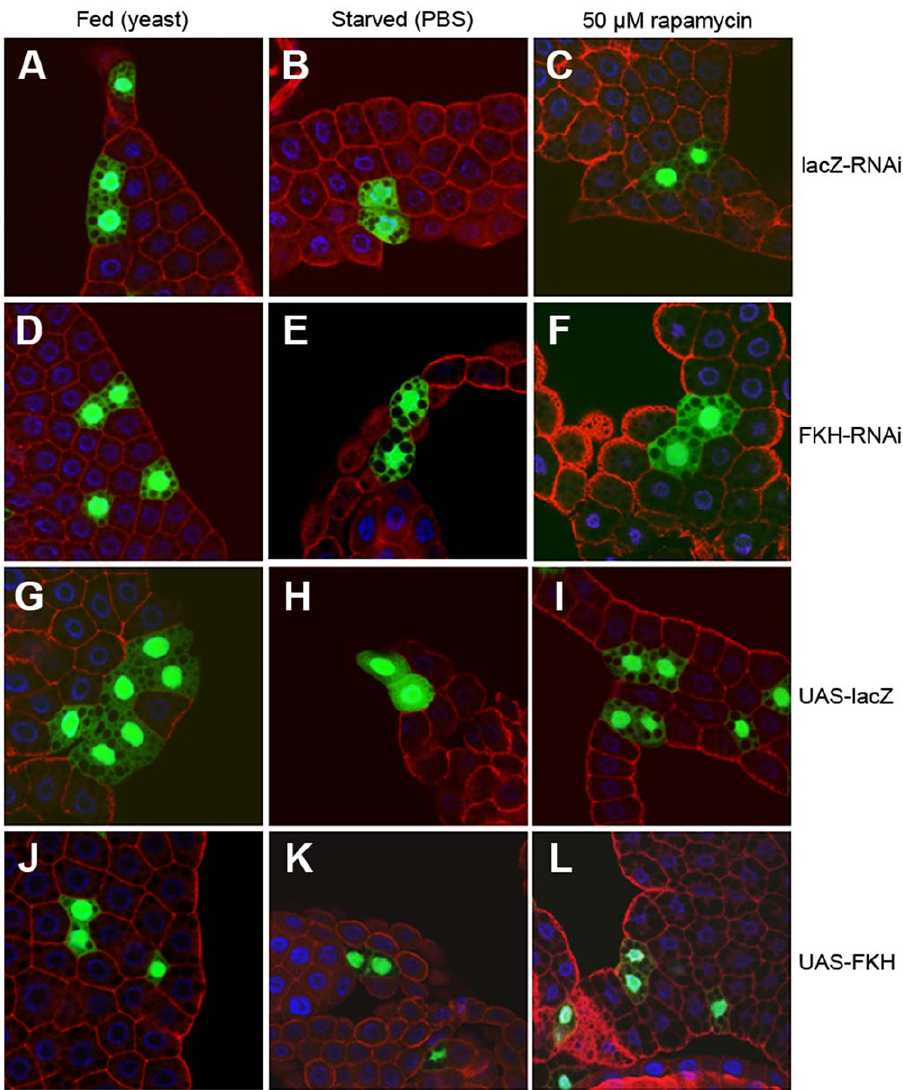
Figure 2. FKH levels influence cell size in the larval fatbody. Pictures show confocal sections of larval fatbodies, using the fly line y w hs-flp;; Act . CD2 . Gal4 UAS-GFP to drive UAS-FKH-RNAi , overexpression and control responder lines. Cells expressing the transgene are marked by the co- expression of GFP, whereas the non-fluorescent serve as wild-type controls within the same tissue sample. Larvae were reared on yeast for 64 h AED, or starved on PBS for 24 h after growing on yeast for 64 h, or treated with rapamycin for 24 h after growing on yeast for 48 h. Tissue was stained with a -GFP (green), a -CD2 (red) and DAPI (blue). ( A – C , G – I ) Controls show no obvious phenotype in the GFP-positive cells. ( D – F ) Cells expressing FKH RNAi have no growth phenotype under fed conditions, but are larger than the surrounding tissue in starved and rapamycin-treated larvae. ( J – L ) Cells overexpressing FKH are smaller than the surrounding tissue under fed conditions.